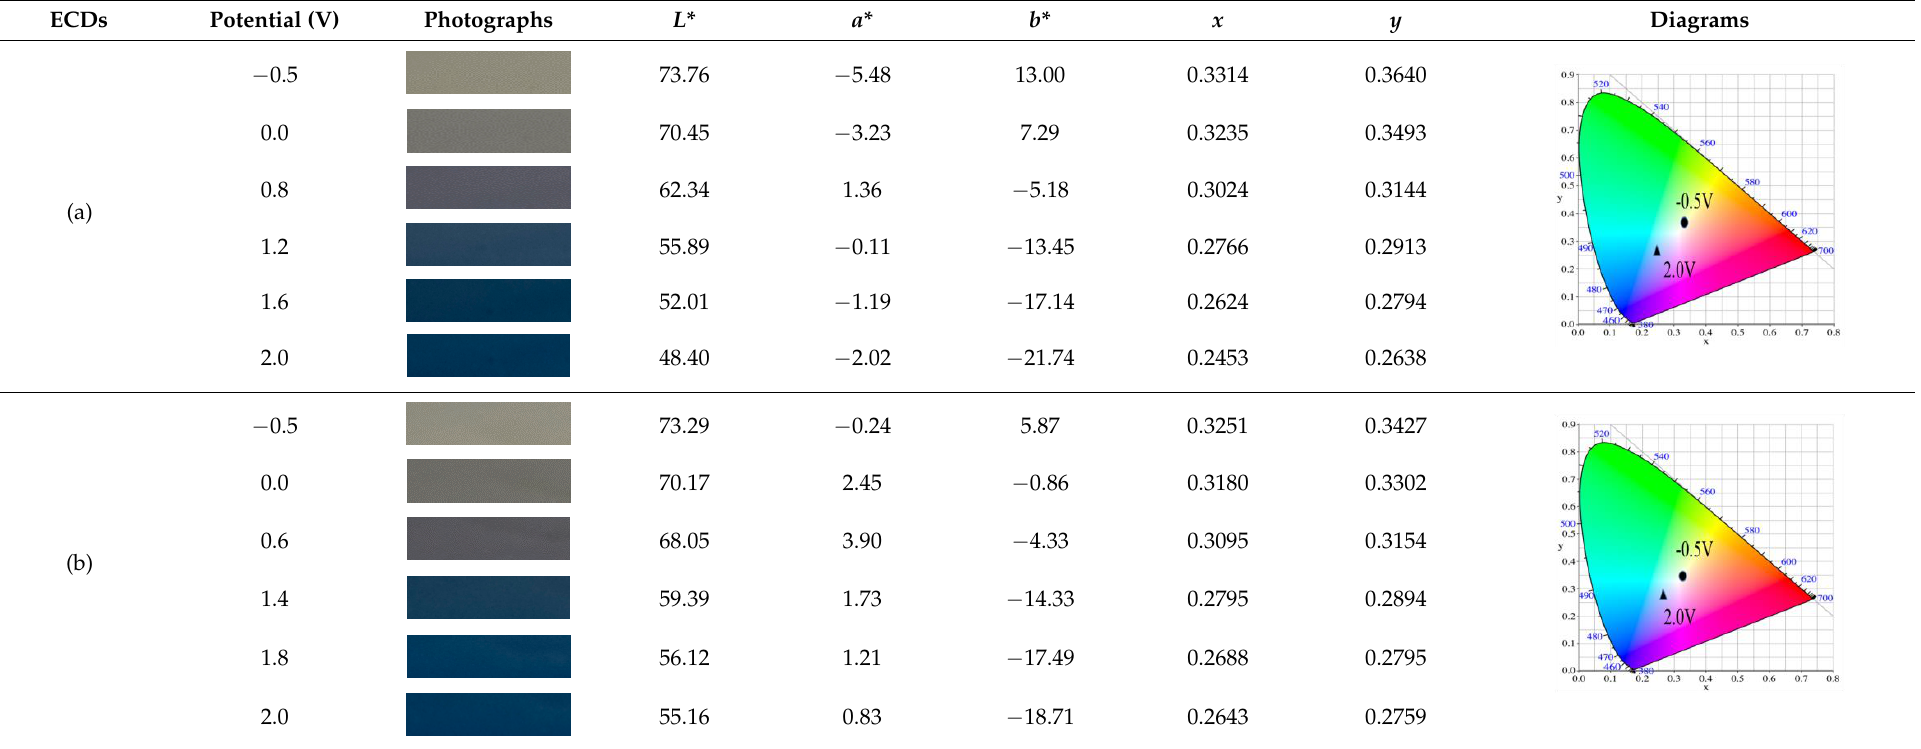
Table 5. Electrochromic photographs, colorimetric values ( L *, a *, and b*) and CIE chromaticity values ( x , y ) of (a) PDTC/PEDOT-PSS, (b) P(DTC- co -BTP)/PEDOT-PSS, (c) P(DTC- co -